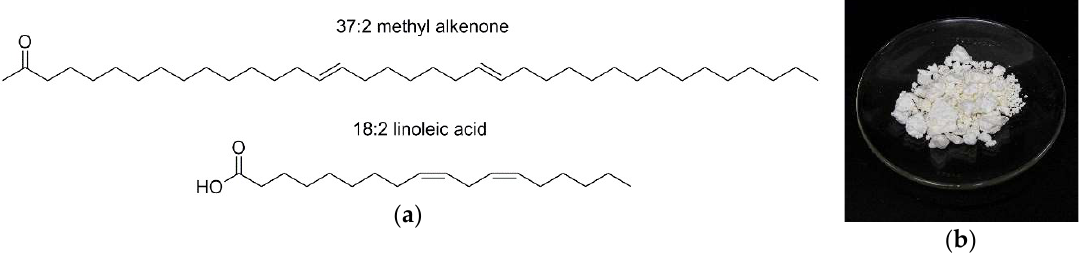
Figure 1. ( a ) Structures of a common alkenone, i.e., 37:2 methyl alkenone, produced by Isochyrsis sp., and a common fatty acid, i.e., 18:2 linoleic acid. Nomenclature for both is # of carbons:# of double bonds; however, note that the configuration and separation of double bonds are different. ( b ) Alkenones wax.